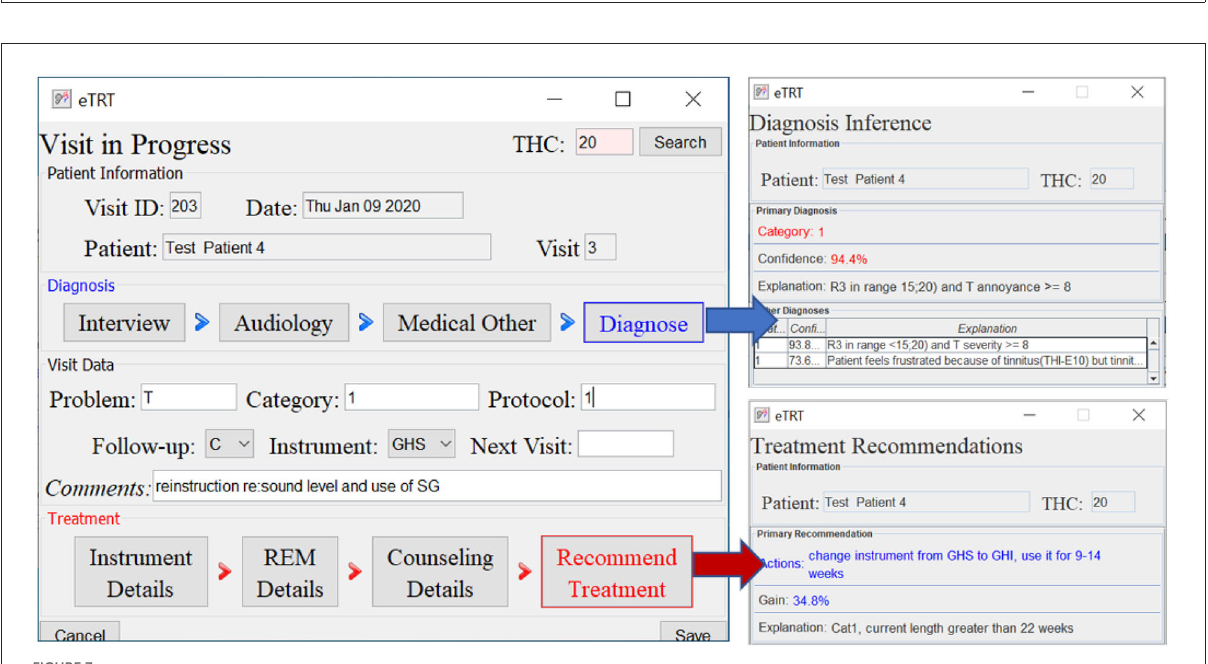
FIGURE7 The diagnostic/treatment inference results for test case 4: (1) category 1 was inferred based on the audiometry results and initial interview (annoyance over tinnitus high); (2) recommendation included the change of the sound instrument from GH soft and shorten its application time to 9–14 weeks with an expected gain of 34.4%